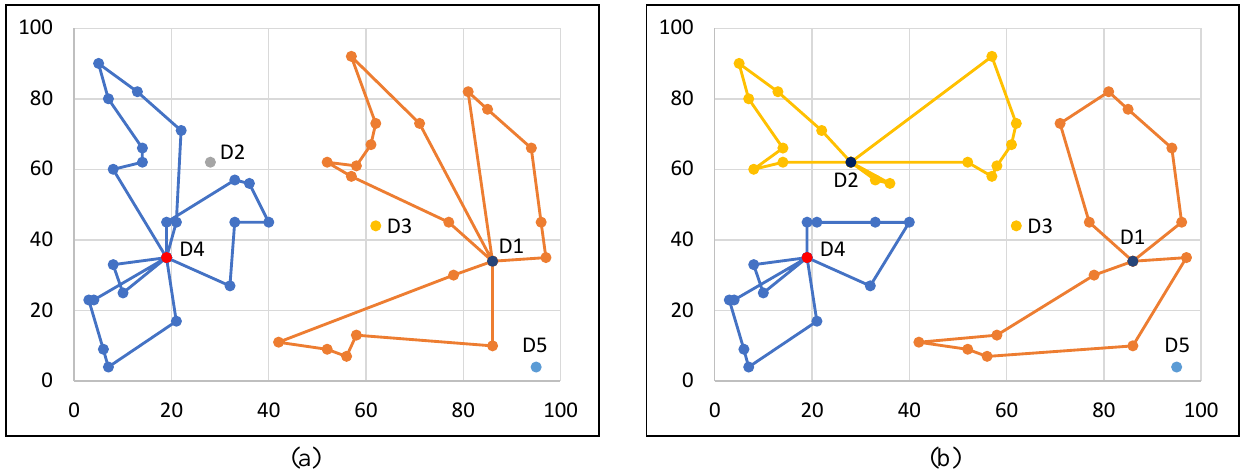
Figure 7. Best-found solution by a nonflexible ( a ) and a flexible ( b ) fuzzy LRP for the instance Cr40x5a-2